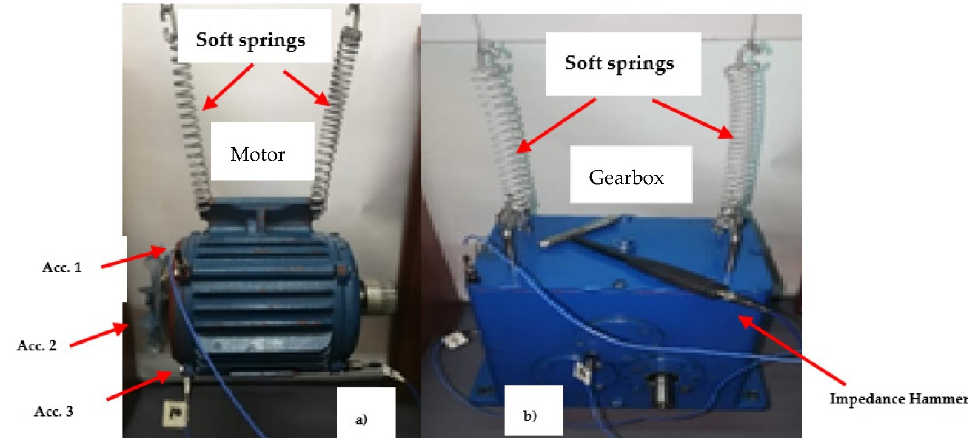
Figure 3. Experimental set up for an induction ( a ) motor and ( b ) gearbox, placed for a free–free condition and excited by an impedance hammer.